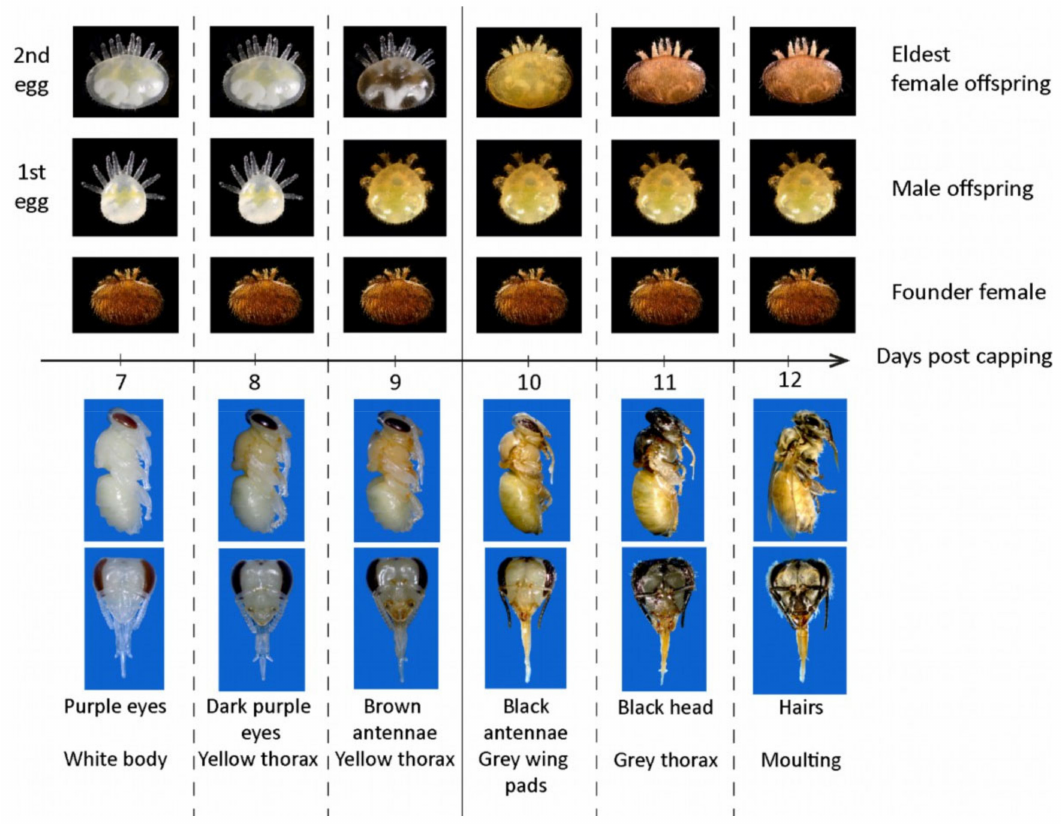
Figure 1. Staging chart used to determine the reproductive success of female varroa mites. Photographs show the average appearance of the development of mite progeny (first two eggs—upper part) in relation to the bee pupal stage (lower part). For bees, the main characteristics used to determine each stage are indicated below the photographs. For mites, the normally expected stage of the eldest female and male o ff spring are indicated above the photographs. If the eldest progeny was at a younger stage than the one corresponding to the illustration of a given bee stage, then the foundress mite was classified as non-reproducing. The solid line placed between day 9 (bees with colored thorax, and white wing pads) and 10 (bees with grey wing pads) days postcapping separates the period before and after which we should expect adult female varroa o ff spring. Source: